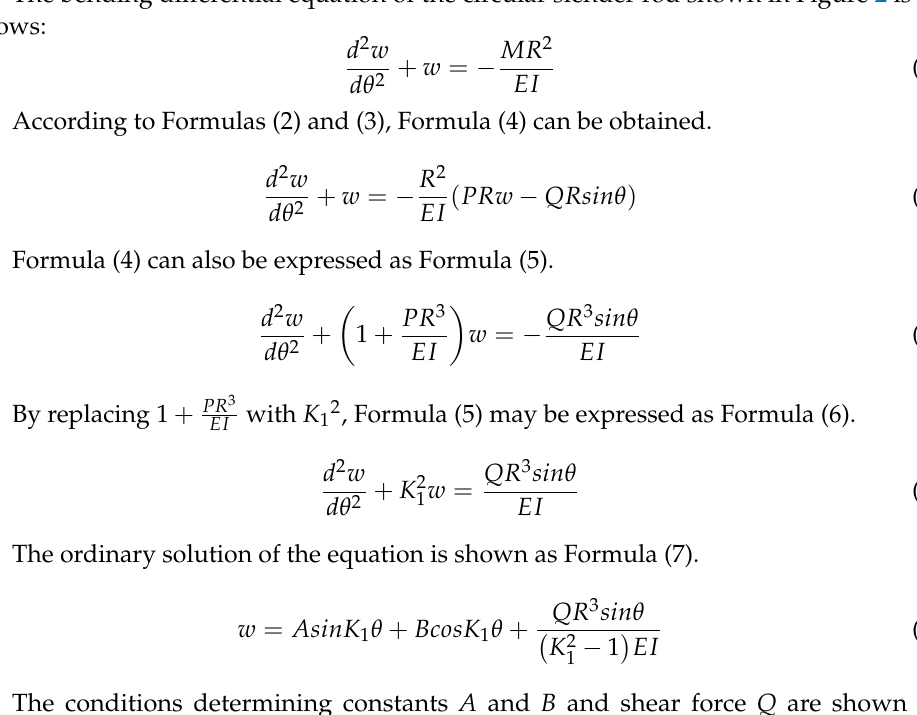
Figure 2. Schematic diagram of theoretical model of rigid–flexible composite lining structure design.